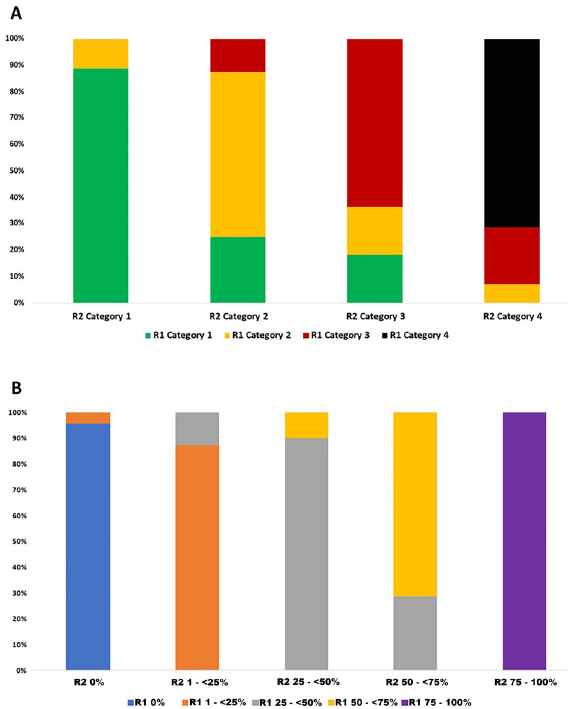
Figure 1. Inter-reader agreement between the two readers for Radiological Society of North America (RSNA) classi fi cation ( A ) and for extent of lung involvement ( B ).